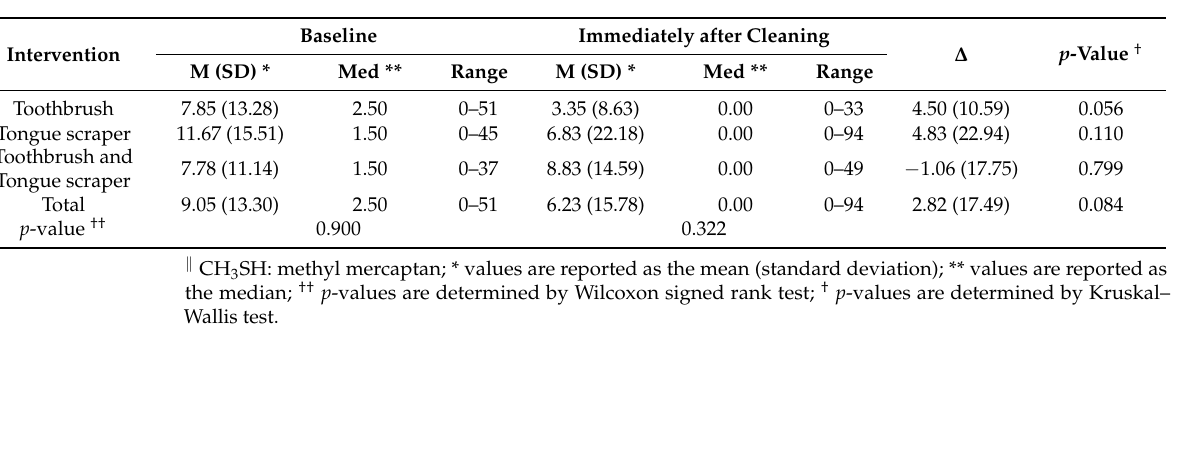
Table 8. Portable sulfide monitor score (CH 3